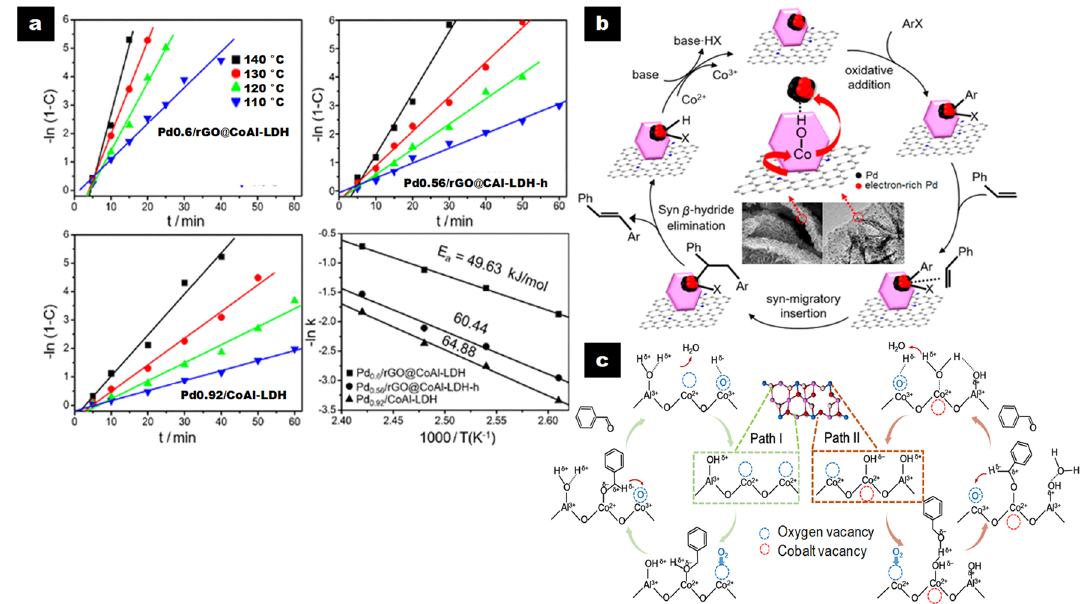
Figure 2. ( a ) − ln(1 − C) against time (t) and Arrhenius plots for the Heck reaction of iodobenzene and styrene on Pdx/rGO@CoAl-LDH at varied temperatures; ( b ) plausible mechanism for the Heck coupling reaction of aryl halides with styrene on Pdx/rGO@CoAl-LDH catalysts. Reproduced